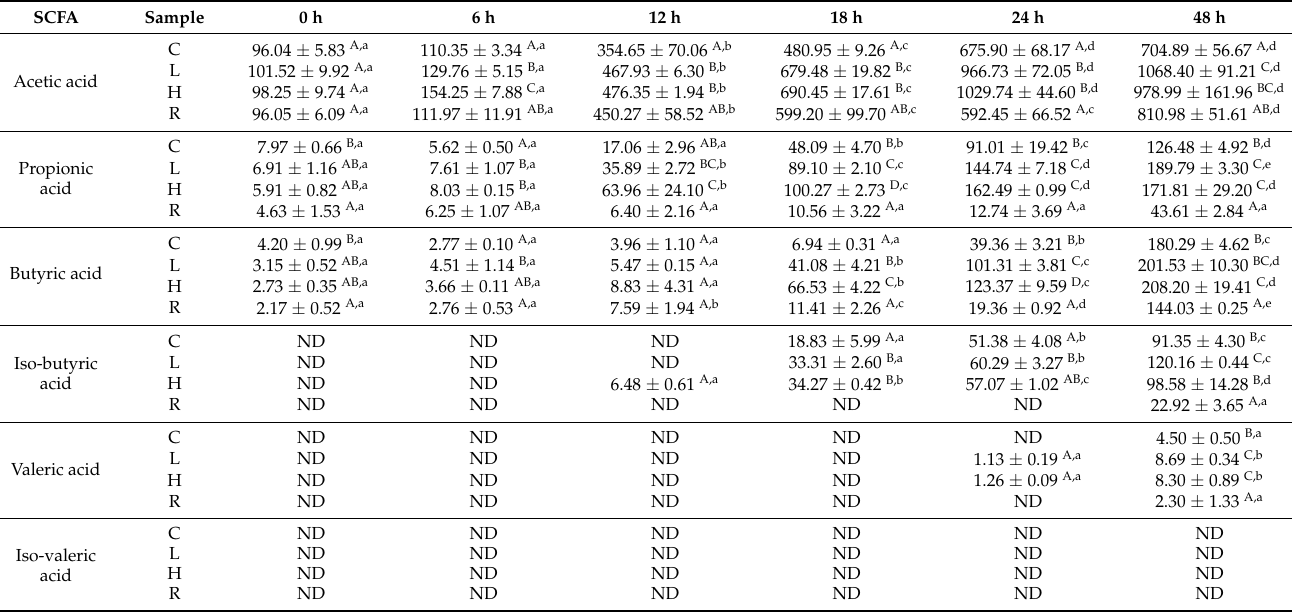
Table 1. Production content of SCFAs during fermentation ( µ mol/mL fermented